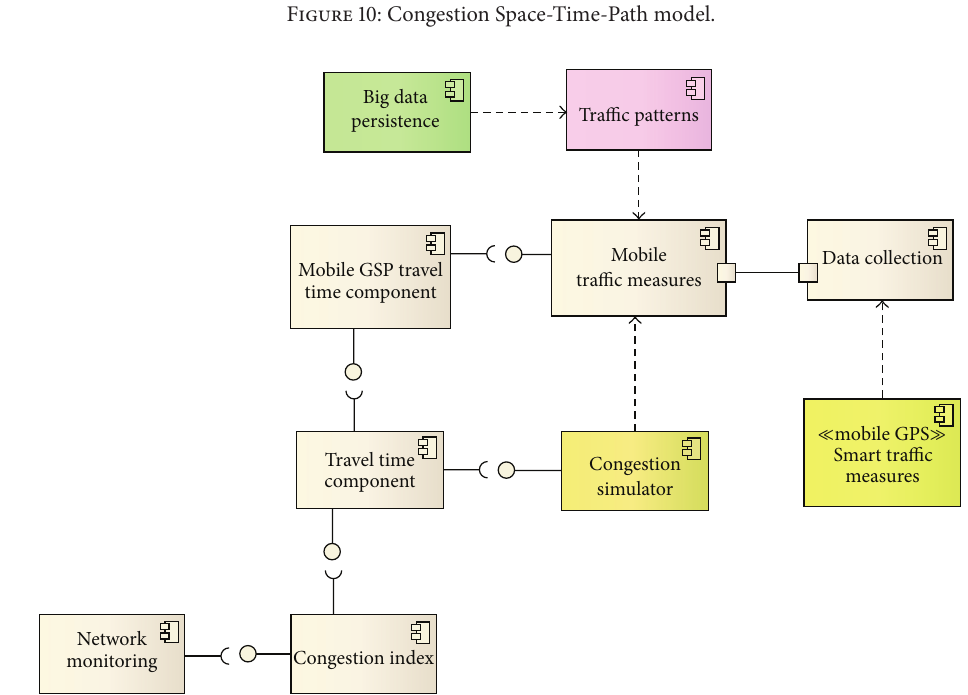
Figure 10: Congestion Space-Time-Path model.